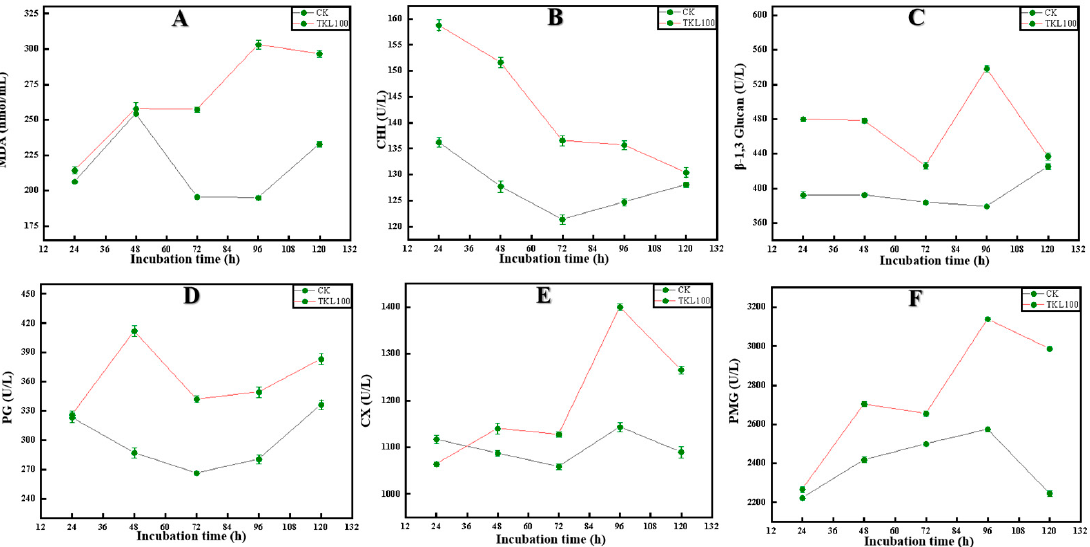
Figure 5. After TKL100 treatment for 24 h, 48 h, 72 h, 96 h, and 120 h, compared with the control group, MDA changes of C. fioriniae ( A ), CHI changes after TKL100 treatment ( B ), β -1,3-glucanase changes ( C ), PG changes ( D ), CX changes ( E ), and PMG changes ( F ). 3.5. Effect of TKL on Surface Disease Changes in Okra Inoculated with the Pathogens